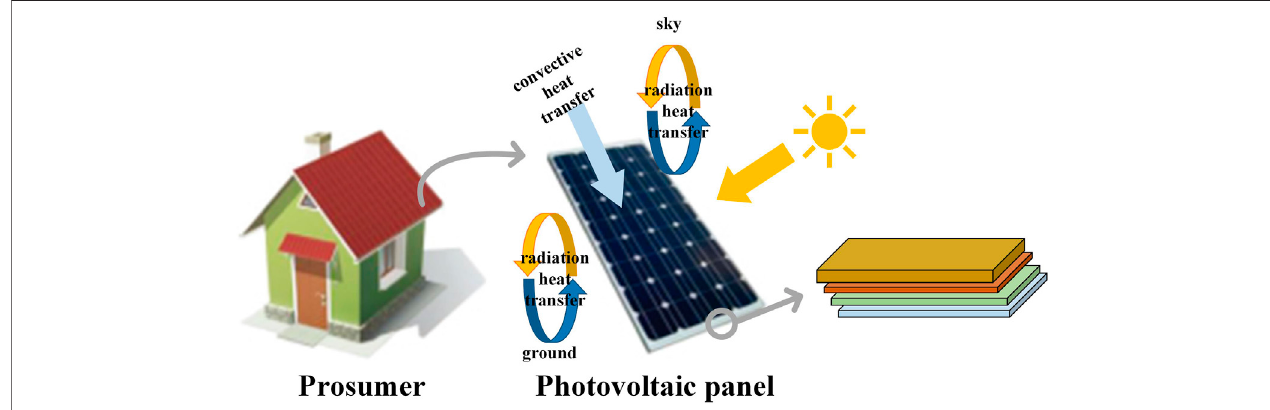
FIGURE 1 | PV module structure diagram.